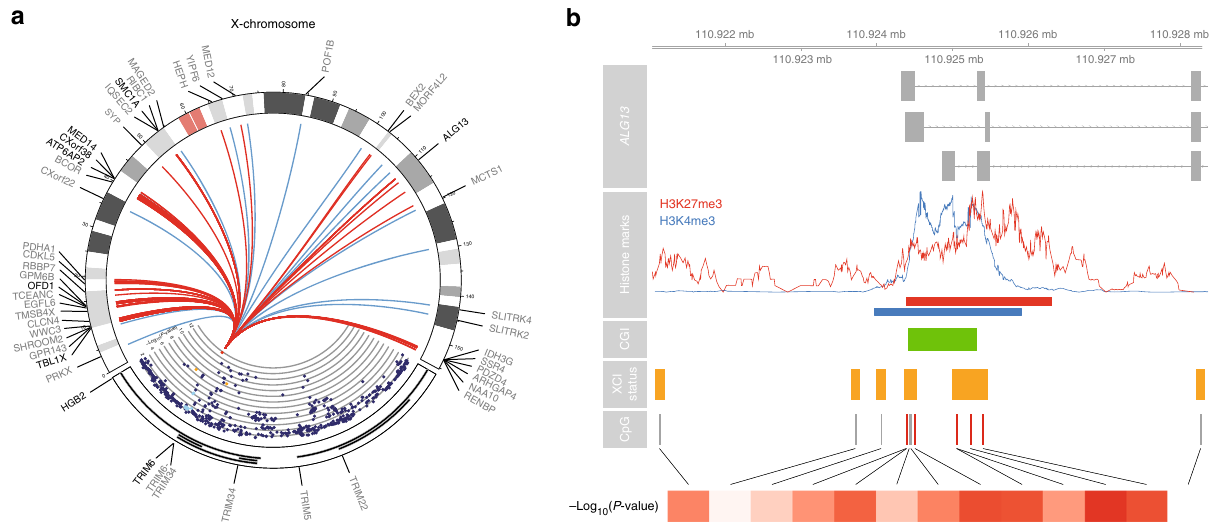
Fig. 3 The TRIM6 / HBG2 locus is associated with DNA methylation at X-chromosomal regions. a Plot showing the TRIM6 / HBG2 locus and the widespread effects it has on the X-chromosome. The colors in the TRIM6 / HBG2 locus indicate LD (red: R 2 ≥ 0.8; orange: 0.6 ≤ R 2 < 0.8; green: 0.4 ≤ R 2 < 0.6; light blue: 0.2 ≤ R 2 < 0.4; dark blue: R 2 0.6 ≤ 0.2). The y-axis shows the – log 10 ( P- value) of the association with overall X-chromosomal methylation. The line colors in the Circos plot indicate the direction of the effect (red: hypomethylation, blue: hypermethylation). The T allele of its sentinel variant rs139916287 is associated with upregulation of HBG2 , downregulation of TRIM6 (both shown in bold), and hypomethylation at 258 of the 276 associated CpGs (93.5%, red lines, mean effect size 1.6% per allele). X-chromosomal genes whose expression levels were associated with methylation levels of nearby CpGs are shown in bold. b Example of CpG island (CGI) in the ALG13 gene associated with the TRIM6 / HBG2 locus. The enrichments of CpGs in certain genomic regions are similar to those found for the SMCHD1 / METTL4 locus. Most notably, the associated CpGs are also overrepresented in regions known to variably escape X-chromosome inactivation 10 (fourth row, orange bars, 8.8-fold enrichment, Fisher ’ s P = 2.1 × 10 − 20